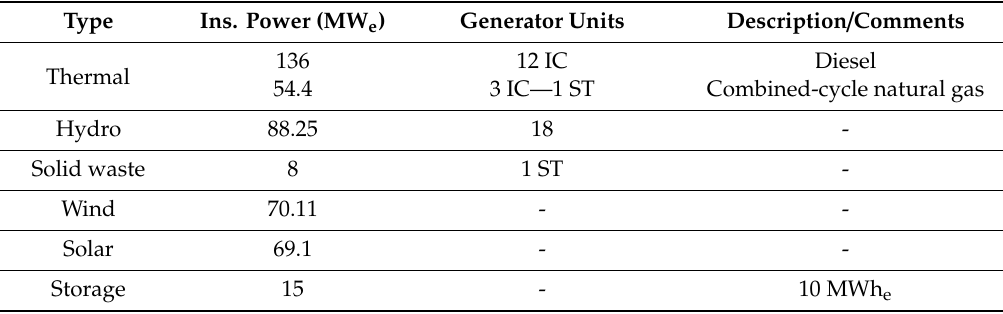
Table 2. Future case production units’ description.